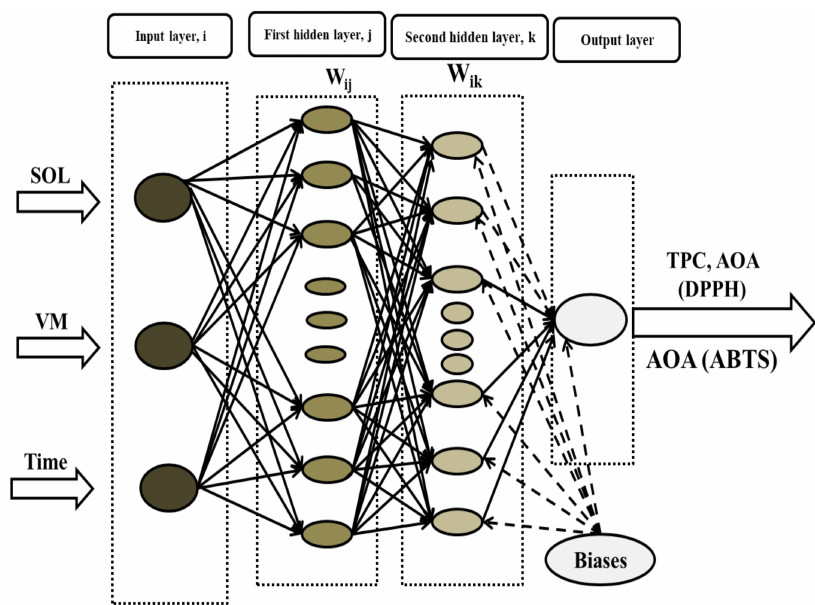
Figure 1. Proposed architecture of MLP ANN. Table 1. Characteristics of identified variables in input and output layers used in the model of ANNs. Input Variables to the ANNs (Units)